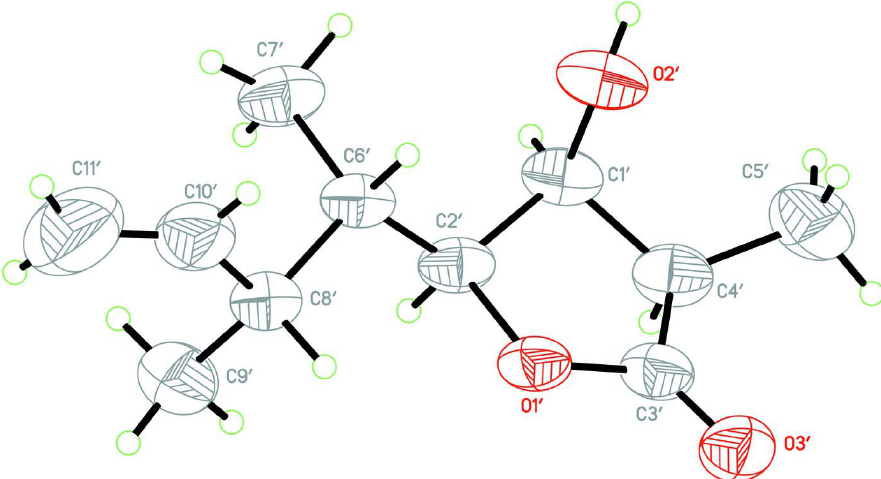
Figure 2 The molecular structure of molecule two of (I), with displacement ellipsoids for the non-hydrogen atoms shown at the 30% probability